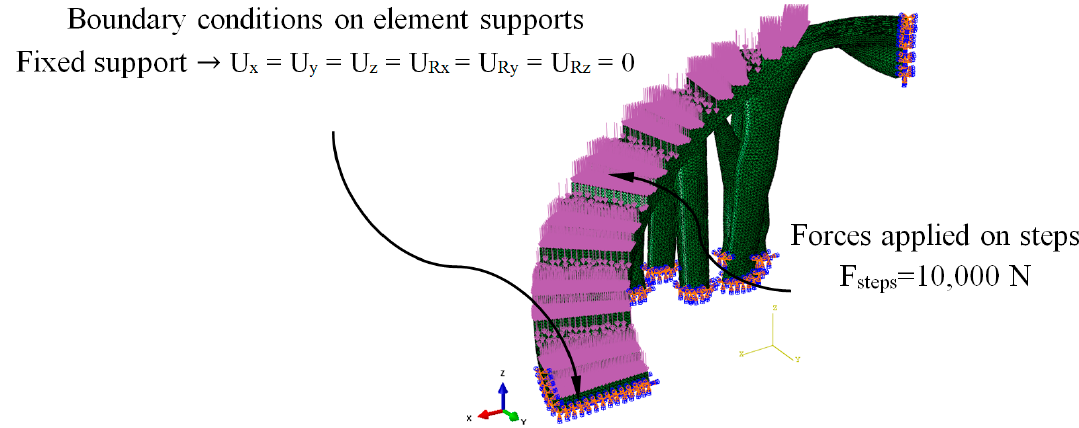
Figure 21. Load scenario and the boundary conditions of the numerical simulations for E 1 .